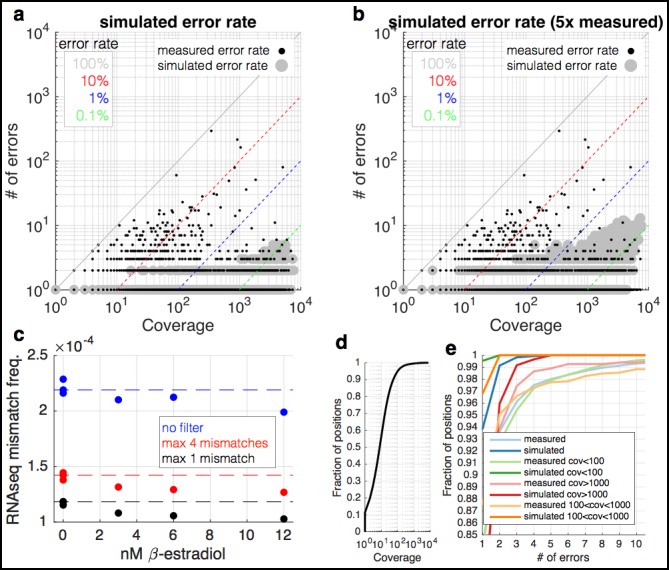
RNA-seq data are enriched for mismatches to the reference genome that occur far more often than expected.(a) At each coverage (x-axis), a point is shown if there is any position in the genome with the observed number of errors (y-axis) (small black dots). The diagonal lines show mismatch frequencies of 100%, 10%, 1%, and 0.1% – any point falling on these lines has the given mismatch frequency. With large grey circles are shown simulated data in which the same coverage as the yeast RNA-seq data are used, but with a mismatch frequency identical to the measured overall mismatch frequency of the yeast data. Locations in the graph in which a black point occurs but there is no grey point are locations in which there are more mismatches than expected by change. Note that at a coverage of <100, we expect to see no mismatches more than twice, and 0.5% of positions with two observances of identical mismatches. (b) Identical to (a) but with the simulated mismatch frequency five times the observed. (c) Shown are measured mismatch frequencies for the yeast RPB9 and DST1 induction data at different β-estradiol concentrations, at different filters for the maximal allowed number of observed identical mismatches. The dashed lines show the average mismatch frequency for the 0 nM condition. For all filters, low β-estradiol conditions have higher RNA-seq mismatch frequencies. (d) The coverage of the yeast RNA-seq data; ~95% of the genome is covered by <100 reads. (e) Shown are the fraction of positions in the genome (y-axis) with X errors (x-axis) for the yeast RNA-seq data (cyan) and simulated data (blue). Also shown are the same data for positions of the genome with different coverage. For positions covered by <1000 reads (95% of the genome) the expectation is 0 or 1 sequence mismatch (blue and orange lines). Positions with far greater numbers of mismatches are likely due to subclonal mutations and technical bias.